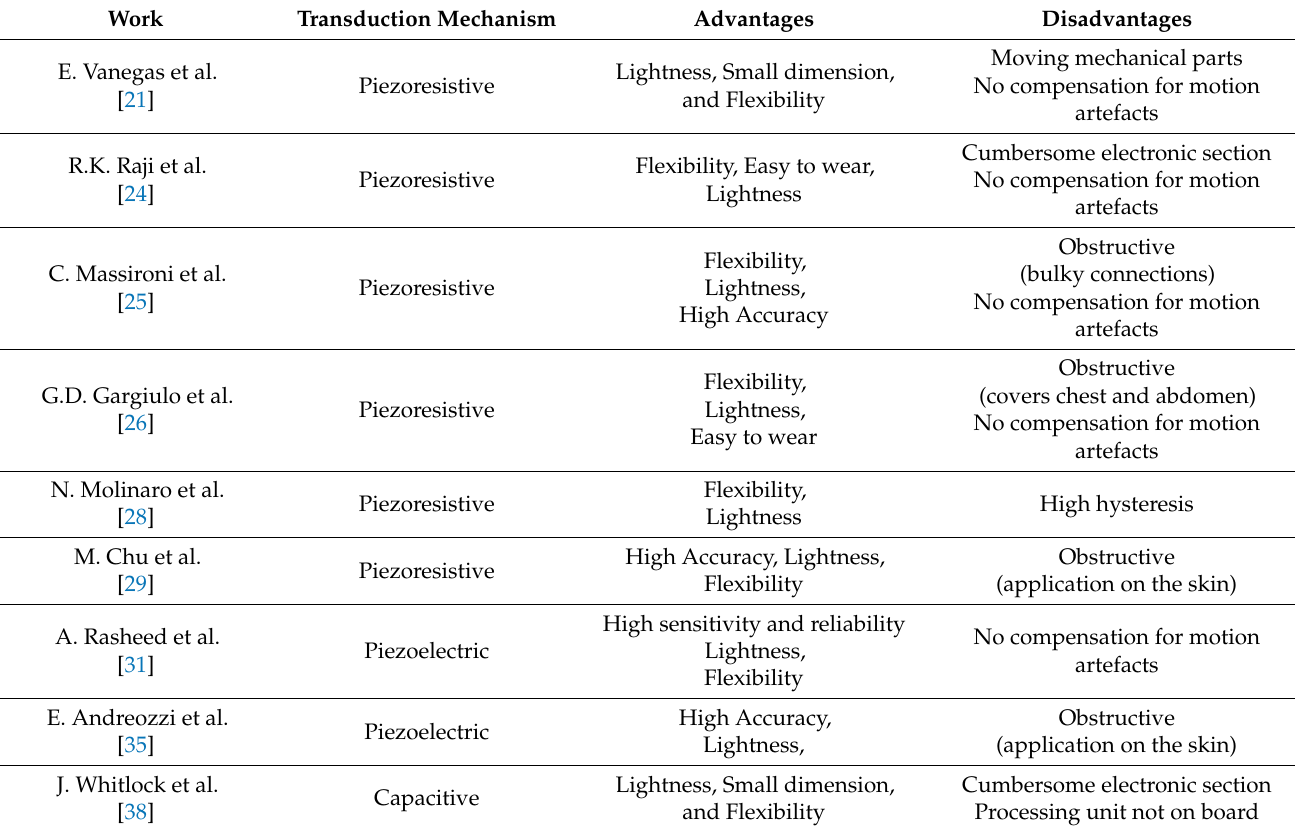
Table 1. Summarizing table with the reported advantages and disadvantages of the discussed